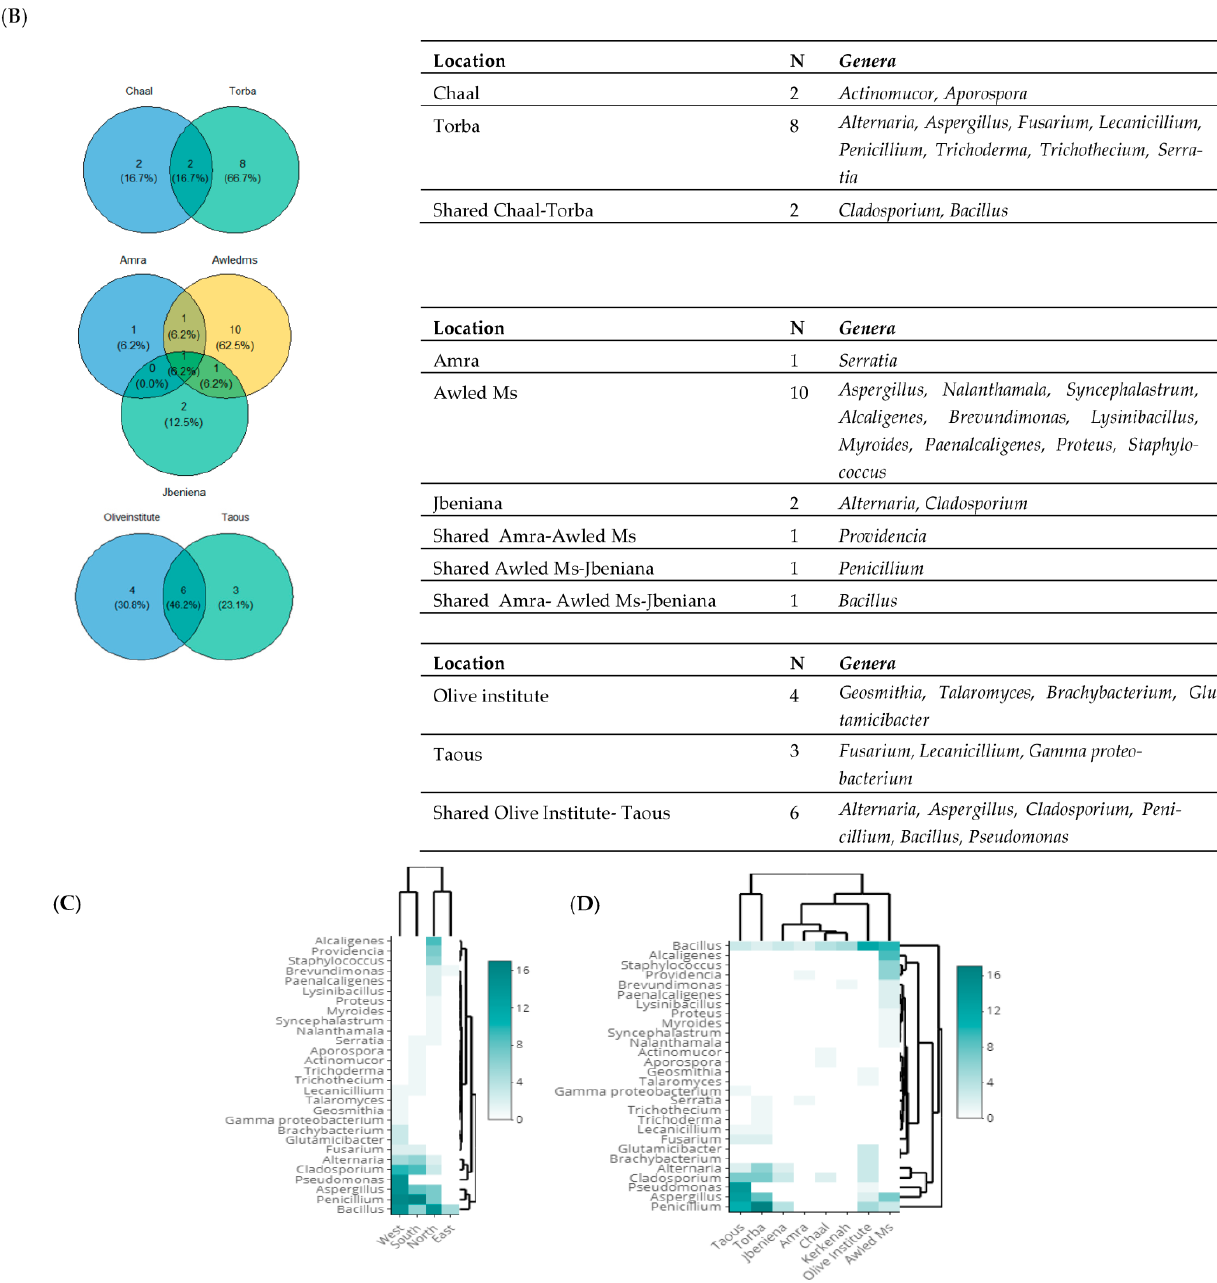
Figure 2. Taxonomic diversity according to the location of isolation from soil and insect ( Prays oleae ). ( A ) Venn diagram comparing the genera isolated from the east, south, north, and west. ( B ) Venn diagram comparing the genera isolated from the south, the north, and the west regions. The list of genera is presented at the right of each diagram. ( C ) Heat map of isolated genera from the east, south, north, and west. The row represents the tested isolate, and the column represents the region. The green color corresponds to the highest values, while the white color corresponds to the lowest one. ( D ) Heat map of isolated genera from the regions. N: Number of genera detected. The row represents the tested isolate, and the column represents the location. The green color corresponds to the highest values, while the white color corresponds to the lowest ones.